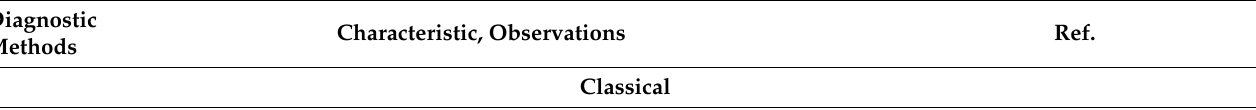
Table 2. Diagnostic methods of the no-reflow